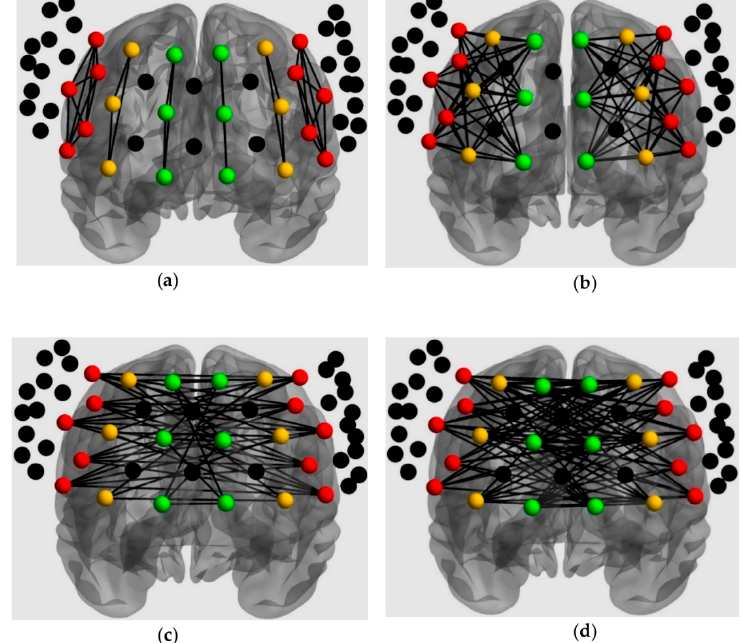
Figure 4. ROIs analysis for connectivity: ( a ) Intrahemispheric connectivity within ROI; ( b ) Intrahemispheric connectivity between ROIs; ( c ) Interhemispheric connectivity within ROIs; ( d ) Interhemispheric connectivity between ROIs.